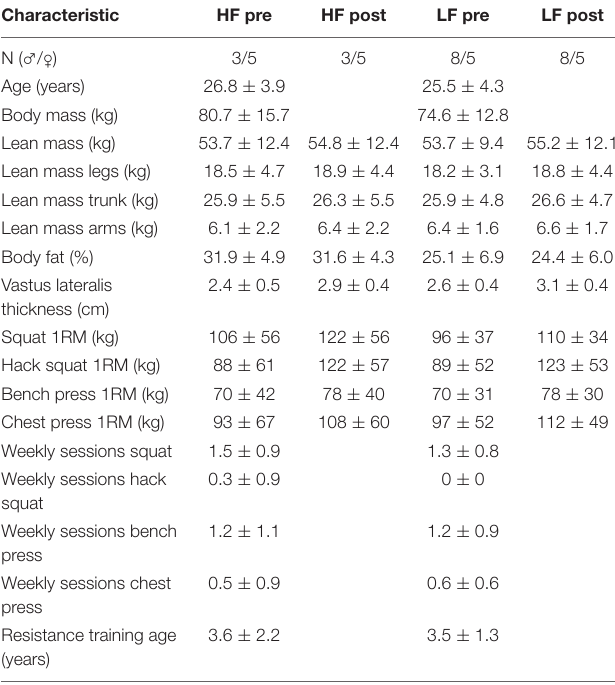
TABLE 3 | Descriptive data of participants before and after 9 weeks of heavy resistance